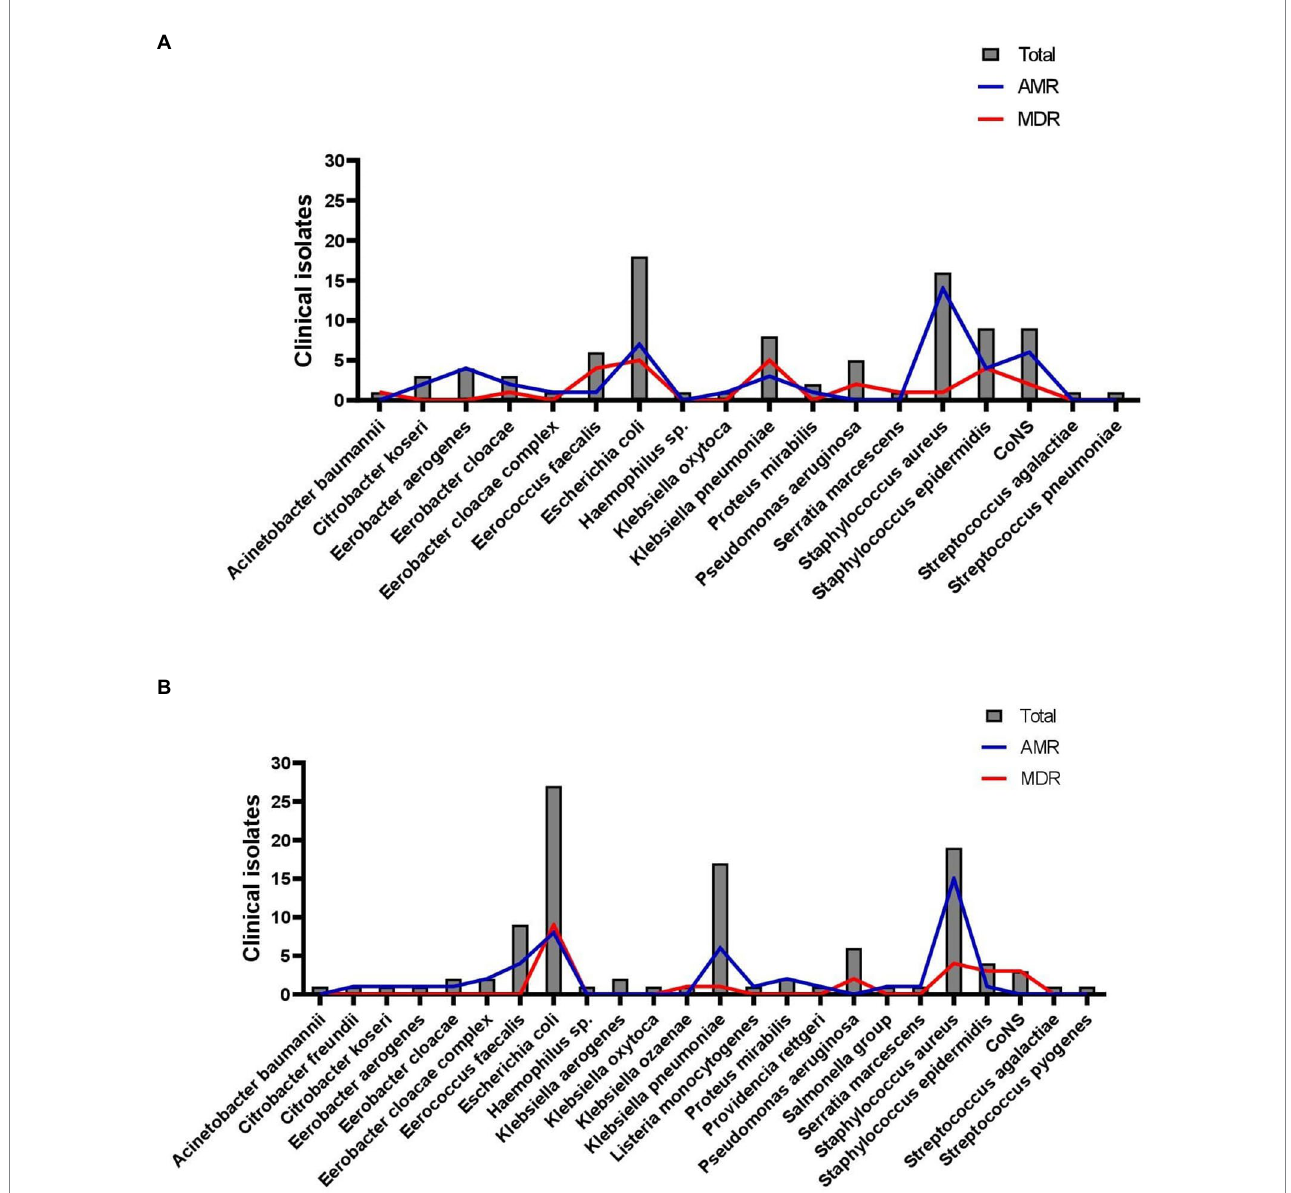
oxazolidone ( S. aureus tested: 100% of isolates with 97% of S), lincosamide ( S. aureus tested: 52% of isolates with 78% of S), tetracycline ( S. aureus tested: 48.5% of isolates with 94% of S) and